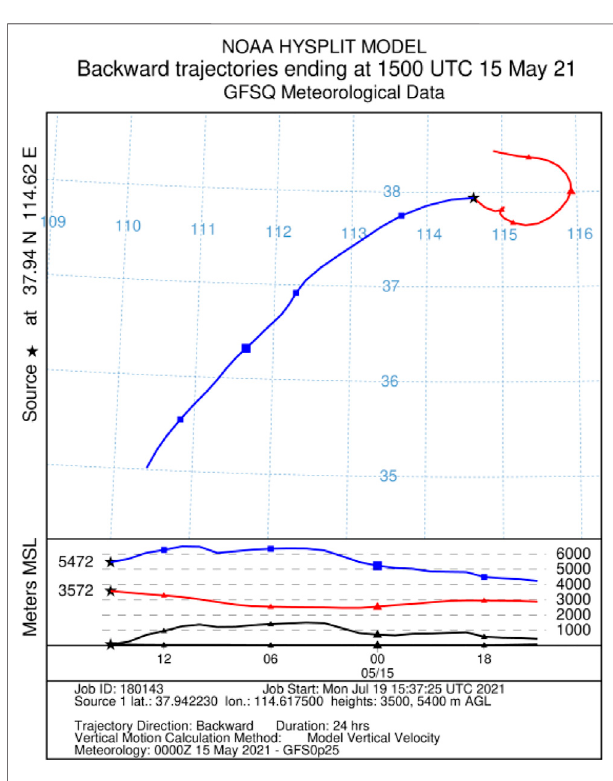
FIGURE 4 | The 24-h backward trajectory of cloud mass in the experiment zone simulated from the HYSPLIT model starting from 15:00 May 15, 2021 (black star). The red and the blue lines represent the trajectory of warm and cold cloud mass at 3,572 and 5,472 m,